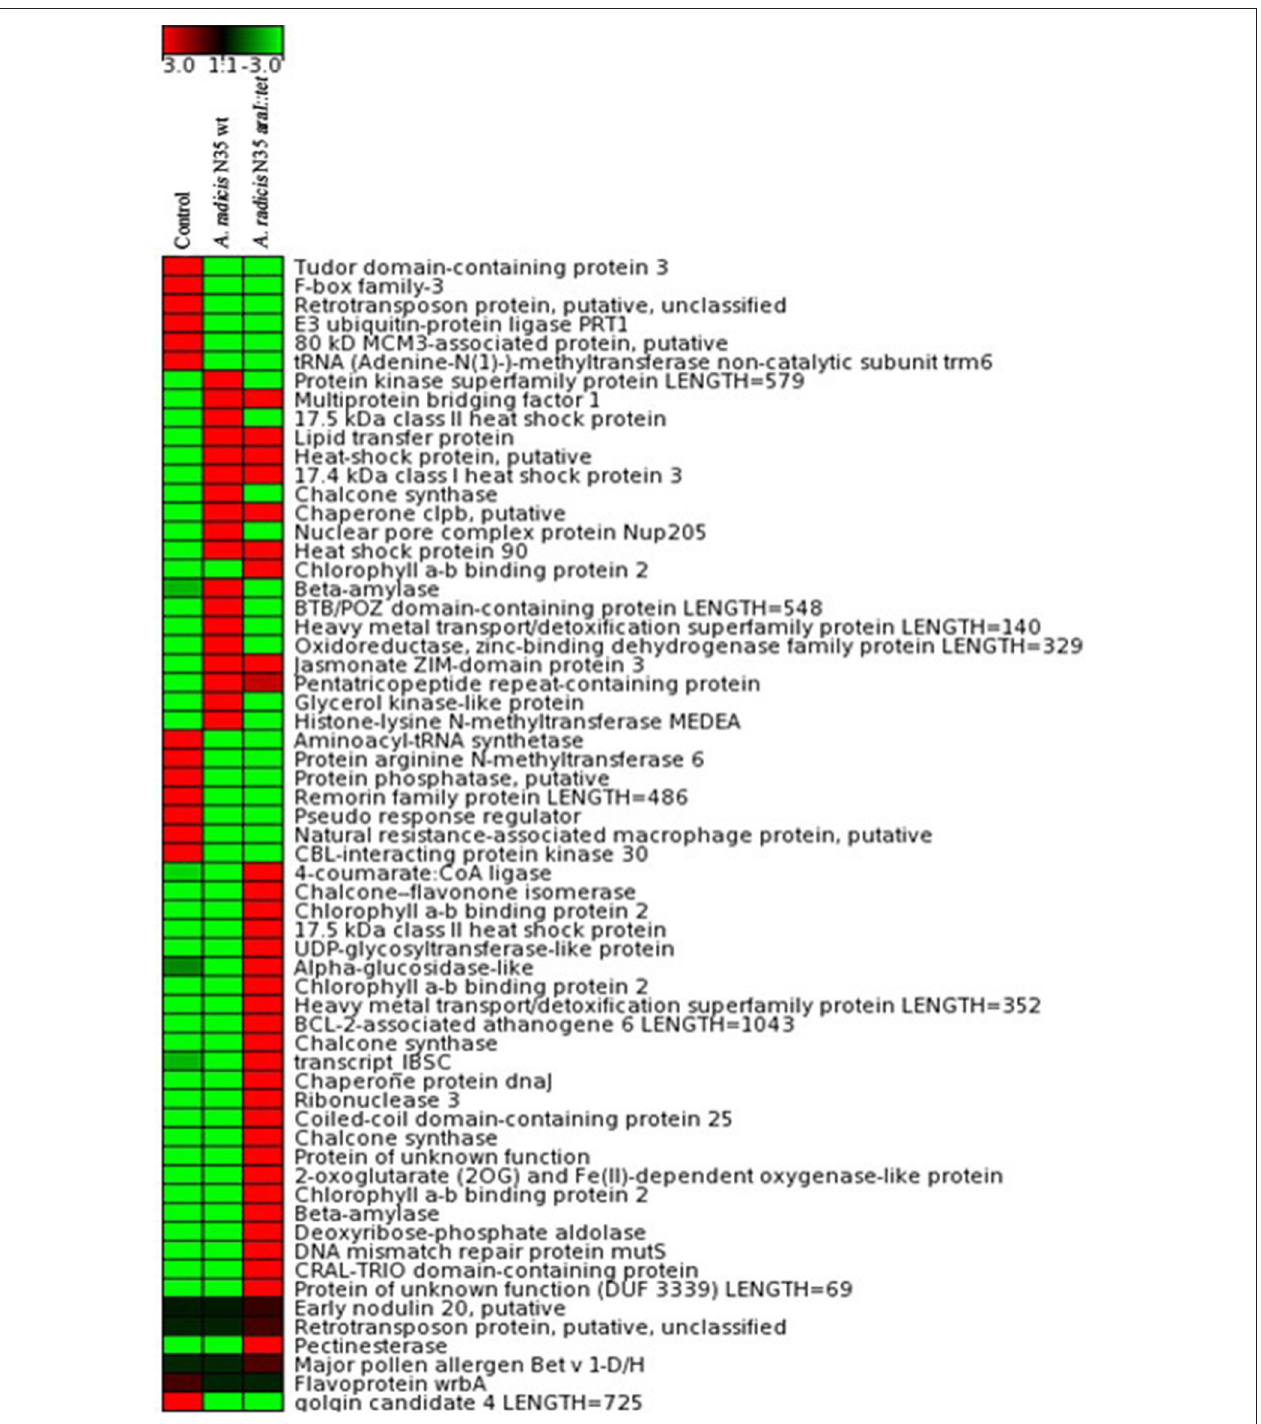
FIGURE 4 | Transcriptome analysis by RNA sequencing from 4 pooled leaves of barley plants grown in parallel. Total RNA was isolated from barley leaves 10 days after root inoculation with A. radicis N35 wild type and the araI mutant, respectively. Red (upregulated) and green (downregulated) colors represent an at least three-fold difference in the amount of detected gene transcripts for the respective gene between the analyzed samples. Black color means no change between the expression levels of the found transcripts.